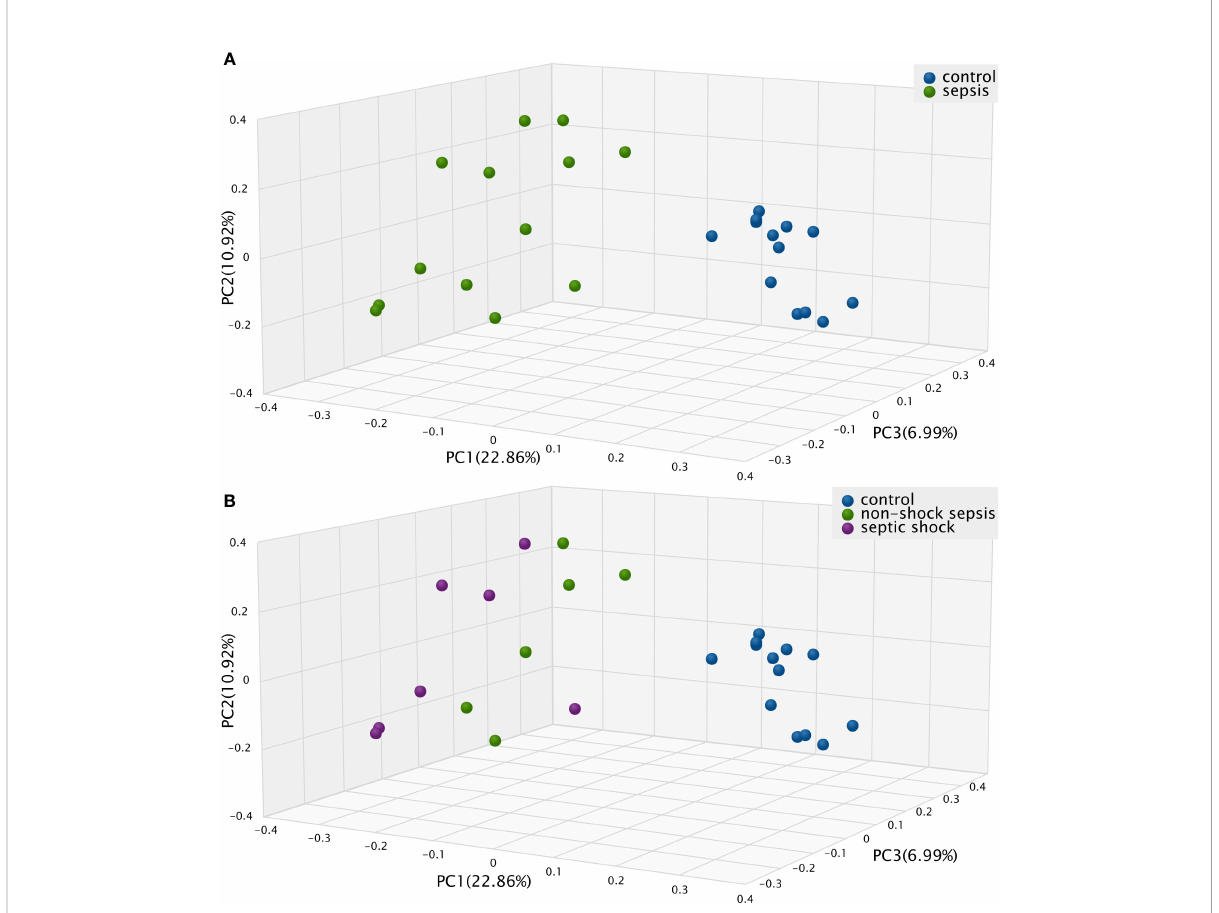
FIGURE 2 The Bray-Curtis Principal Component Analysis (PCoA) Beta diversity between (A) septic and control patients; (B) patients with non-shock sepsis, septic shock and control patients: The difference of beta diversities between control/septic, control/non-shock septic and control/septic shock patients are signi fi cant. There is no signi fi cant difference between the two septic